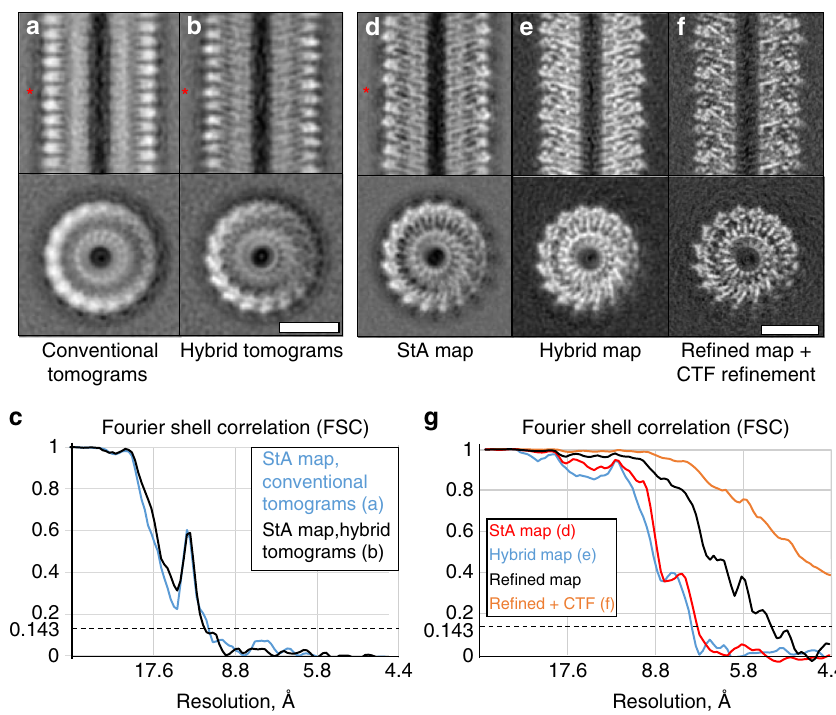
Fig. 3 Resolution improvement by the application of hStA to TMV. a – c Structures of TMV ( a , b ) and the corresponding FSC curves ( c ) as processed by the conventional subtomogram averaging work fl ow. The dataset in a was recorded using a conventional dose-symmetric scheme and in b using the proposed hybrid scheme. Note the “ halos ” observed next to the density in e , f and marked with the asterisks. d – g Processing of a larger dataset of hybrid tomograms of TMV: d conventional StA map; e Hybrid map, reconstruction only from the high-dose image; f and the re fi ned map with the re fi ned CTF; g the corresponding FSC curves. Scale bars: 10